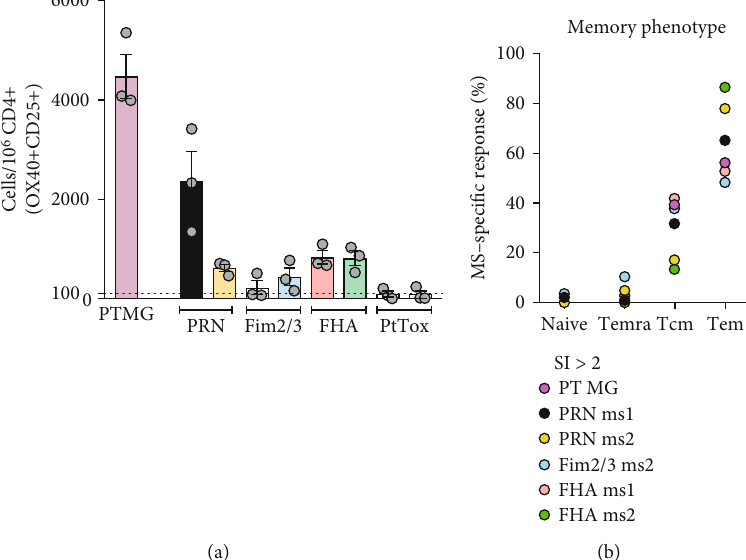
Figure 5: Ex vivo AIM assay pool screening on di ff erent days reproducibly identi fi es candidates for deconvolution. (a) % of BP-speci fi c CD4+ T cells for the pool of aP antigens (PT) or for the 8 MSs containing peptides from the 4 individual aP antigens was measured by the AIM assay. Peptides from the 4 individual antigens are aligned by ORF position but fl anked by peptides from other antigens and unequally distributed over 2 adjacent and unique MSs each. Individual circles represent an independent technical replicate of the same donor performed on a di ff erent day. A representative donor is shown. Data are expressed as mean ± SEM . Dotted line indicates positive response threshold of 100 cells set to identify MS candidates for deconvolution. (b) Memory subset composition of PT MG- and MS-speci fi c responses ( SI > 2 ) is shown as % of total CD4+ T cells gated in AIM-positive cells (Tn: CD45RA+CCR7+, Temra: CD45RA+CCR7-, Tcm: CD45RA-CCR7+, and Tem: CD45RA-CCR7-). The average data for each positive mesopool are shown ( n = 5